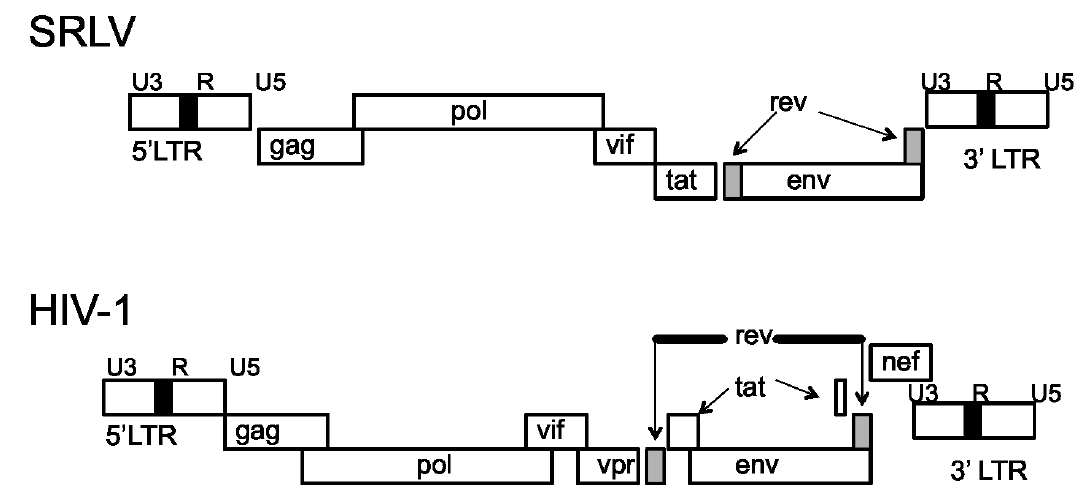
Figure 1. Genomic organization of small ruminant lentiviruses (SRLV) and HIV-1